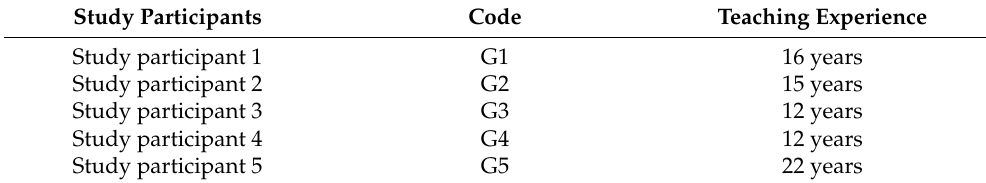
Table 1. Demography of study